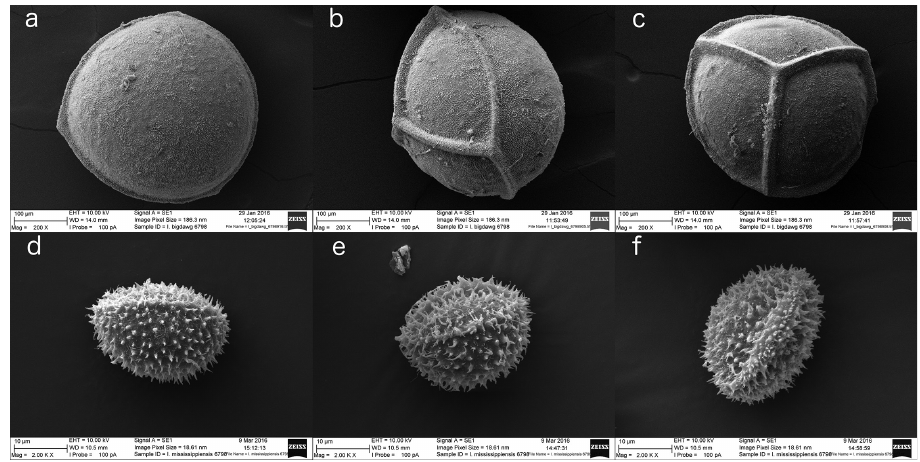
Figure 1. SEMs of megaspores ( a, b, c ) and microspores ( d, e, f ) of I. mississippiensis displaying distal ( a, d ), equatorial ( b, e ), and proximal ( c, f ) views. Megaspores from Schafran MS-08, microspores from